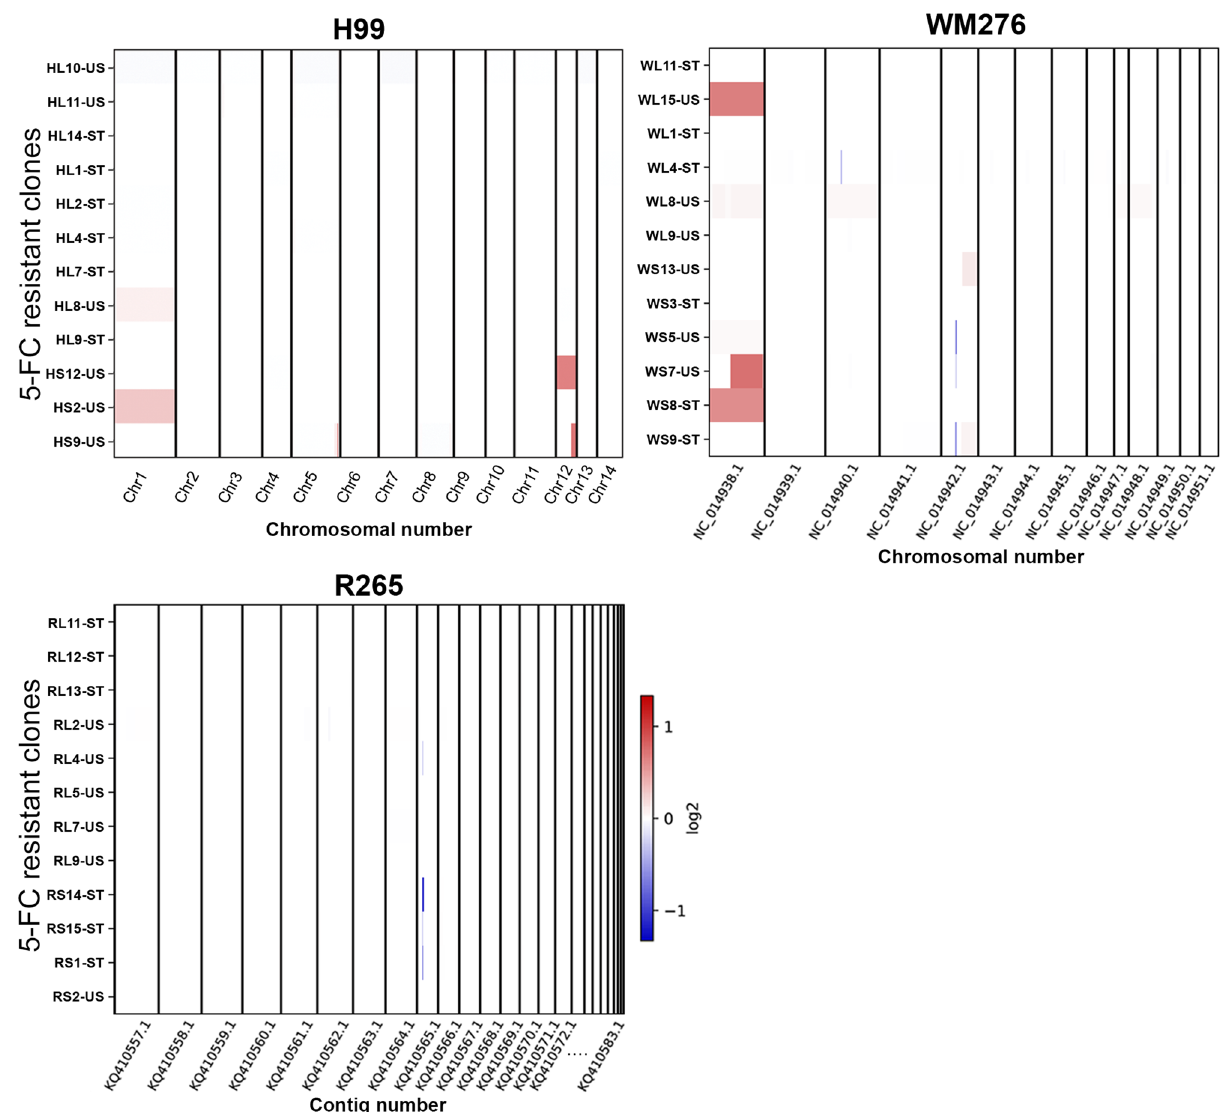
Fig. 2 Chromosome copy number analysis. The genomic sequences of twelve 5-FC resistant clones each from H99, R265, and WM276 were determined, and the copy number of each chromosome was calculated. The change of copy number is represented by the intensity of the color. The red color represents copy gain and blue color represents copy loss in units of log2 as shown by the color scale. The color bar represents the location of copy number change in the chromosome. The name of chromosome or contig is indicated at the bottom of each panel and the width of the column represents the size of chromosome or contig. The name of each clone is on the left side of each panel. The “ L ” and “ S ” in the name represent the size of the colony at the time of its isolation and ST and US in the suf fi x indicates the stability of each 5-FC resistant clone as either stable or unstable,